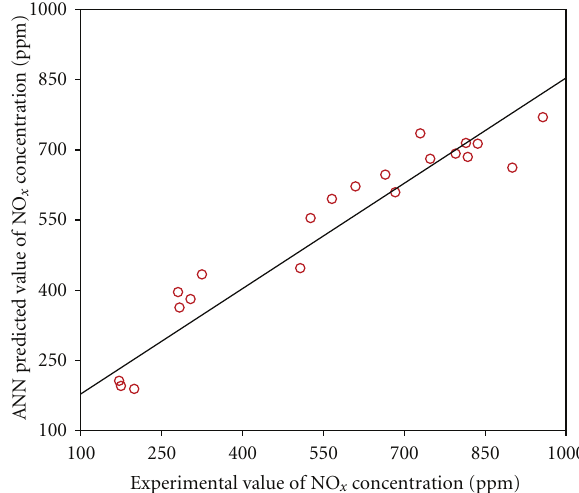
Figure 10: Comparison between ANN predicted values and the corresponding actual values for NO x concentration.